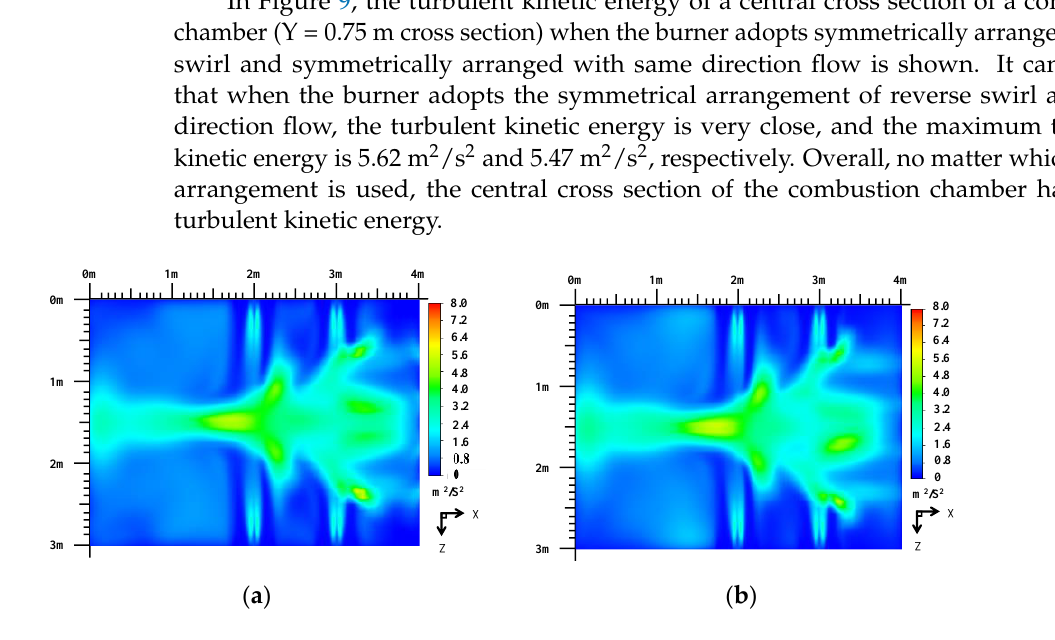
Figure 9. A cloud diagram of turbulent kinetic energy in the cross-section of the center of the combustion chamber (Y = 0.75 m). ( a ) The burner is symmetrically arranged with re-verse swirl. ( b ) Symmetrical arrangement of burners with same direction flow.